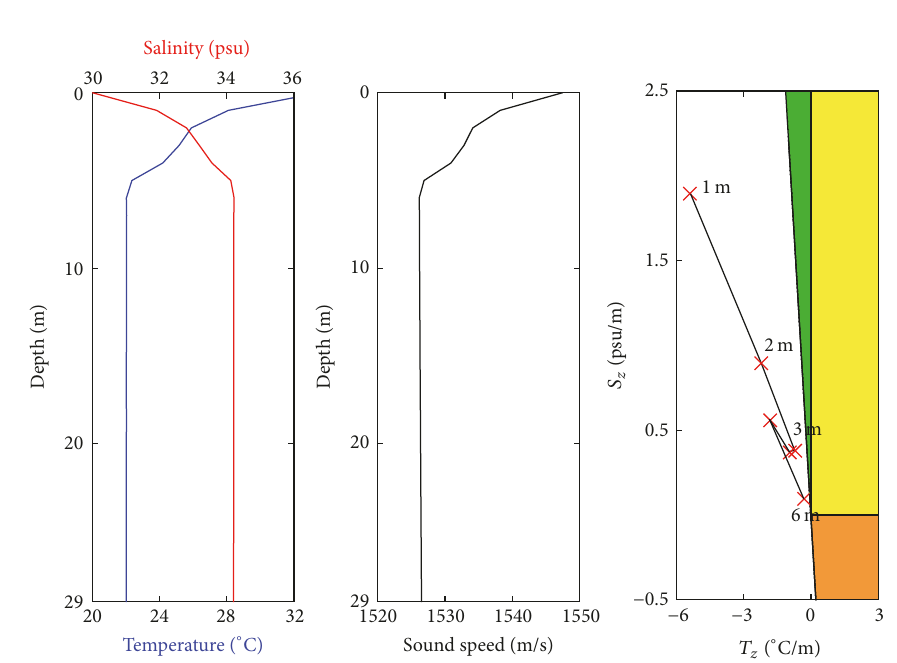
Figure 5: Offshore upwelling